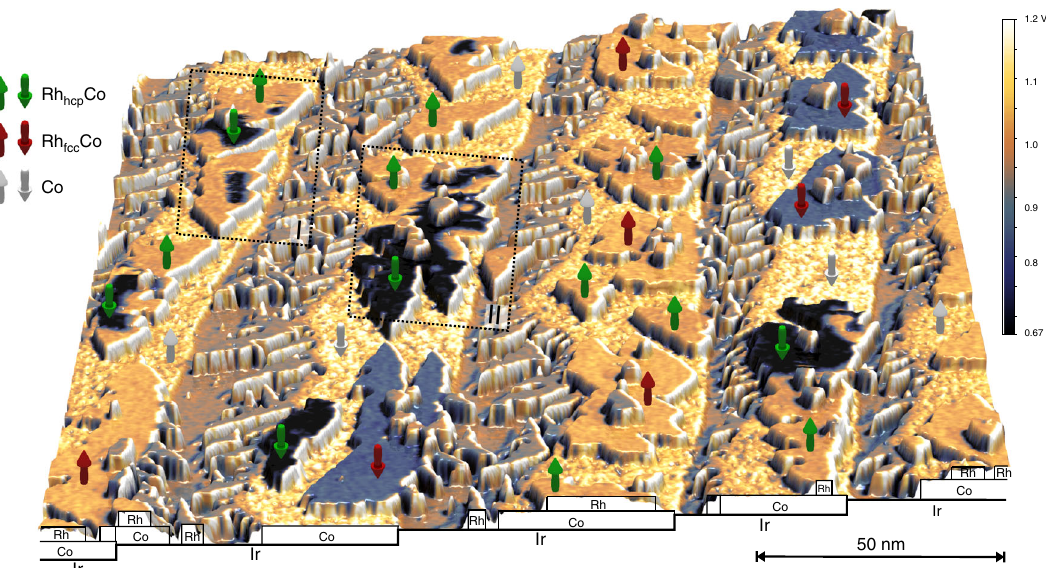
Fig. 1 STM measurement of Rh/Co/Ir(111) in the magnetic virgin state. Perspective view of STM topography colourized with a simultaneously measured spin-resolved dl/dU map of 0.4 atomic layers of Rh deposited on 0.5 atomic layers of Co on Ir(111). The front cross-section has been sketched and labeled for clarity. Co (indicated by white arrows) grows as stripes form the Ir(111) step edges. Rh covers some of the exposed Ir(111) surface. The stacking of the Rh on the Co monolayer is indicated by the color of the arrows. The directions of the arrows indicate the local magnetization direction. The two black rectangles mark the zoom-ins shown in Fig. 2. ( U = − 250mV, I = 800 pA, B = 0 T, T = 4.2 K), Cr bulk tip, fast scan axis is horizontal)